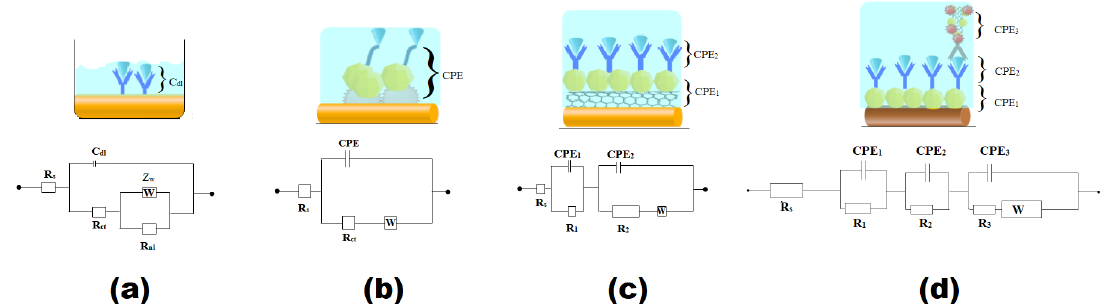
Figure 3. Electrode interface of different ECIA scheme with their equivalent circuits: ( a ) dECIA [100], ( b ) dECIA with nanolabel of Ppy/AuNP and aptamer specific to IL-6 for binding analyte [101], ( c ) dECIA with electrode coated with SWNT (single-walled carbon nanotubes)/AuNP [103], and ( d ) sELECIA with nanolabel of CNT/AuNP and enzyme label Horseradish Peroxidase